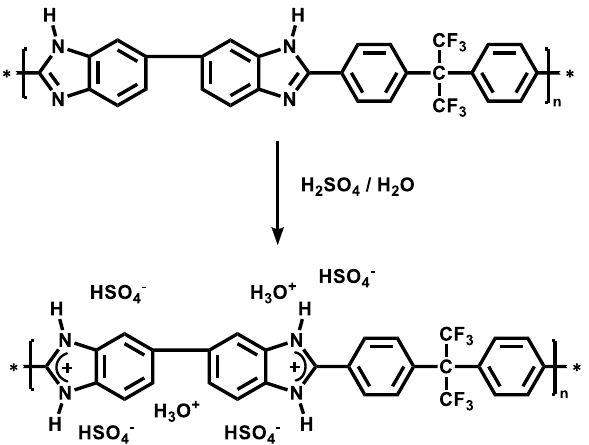
Figure 4. The protonation of partially fluorinated and highly stable polybenzimidazole (F6-PBI) when doped with sulfuric acid [31].